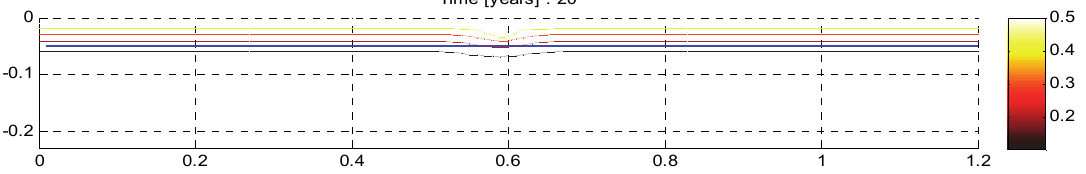
Figure 3: The sample isolines plot of concentration of chloride ions in a concrete bridge deck with a crack. Assessment of